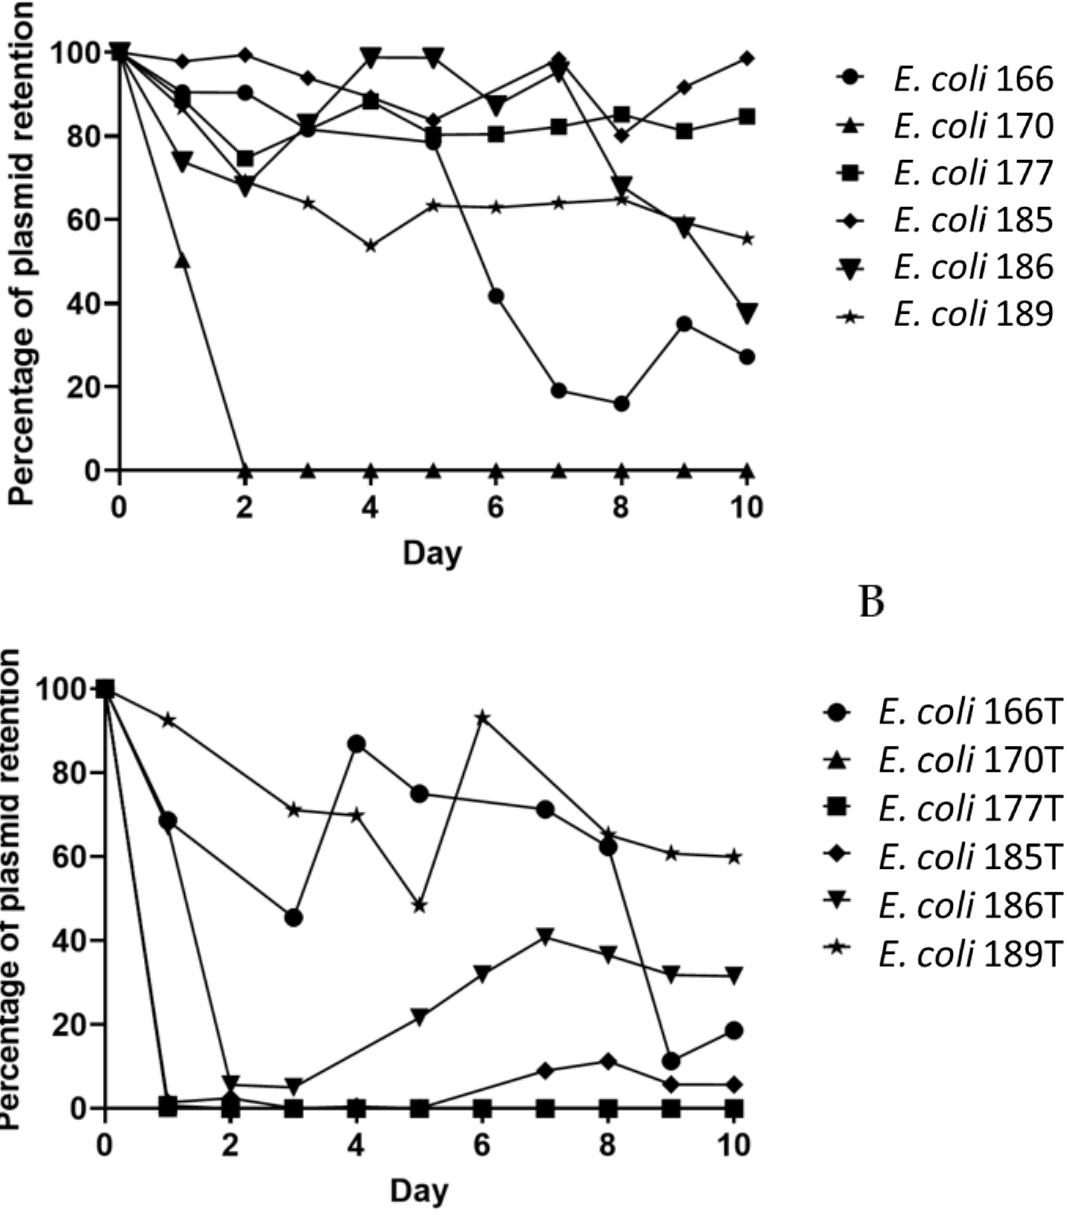
Figure 2. Stability of mcr-1 plasmids. Assessment of E. coli donor strains ( A ) and its transconjugants ( B ) over 10 days in the absence of colistin.